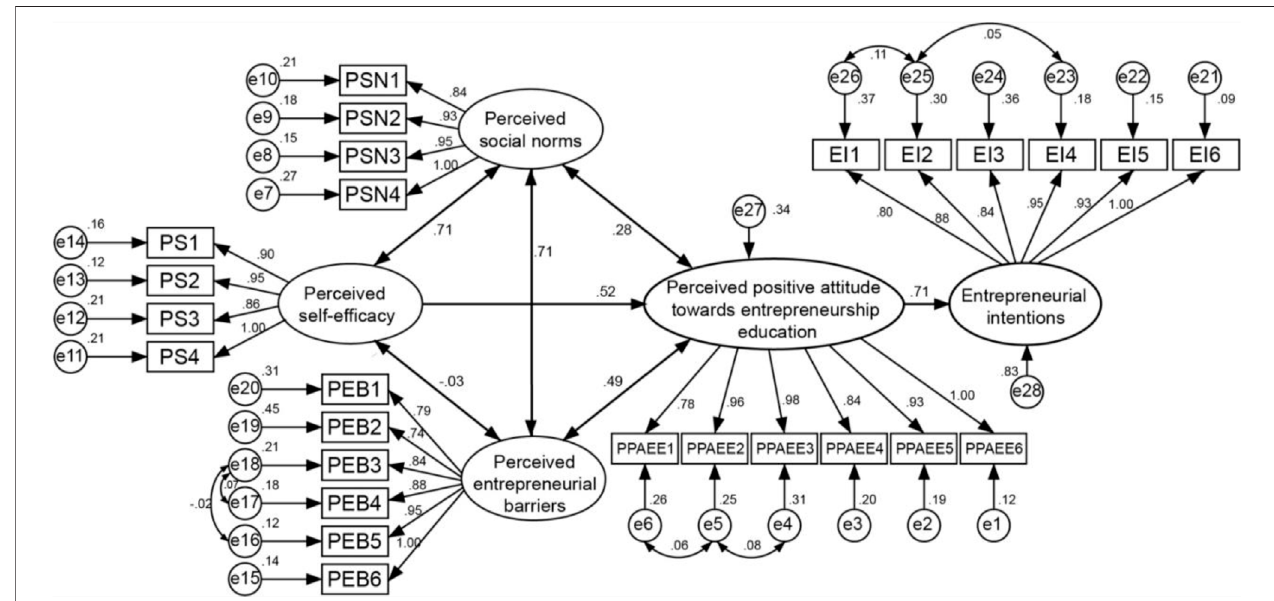
FIGURE 2 | The result of structural equation model.